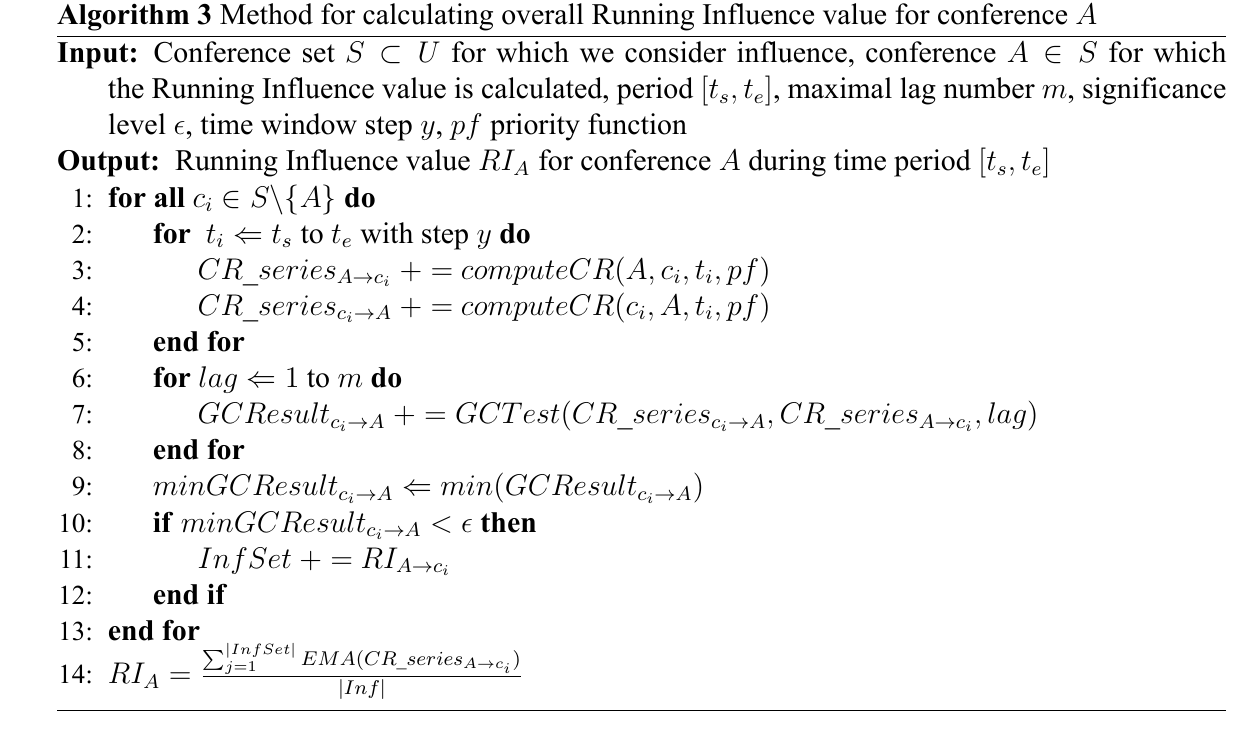
Algorithm 3 Method for calculating overall Running Influence value for conference A